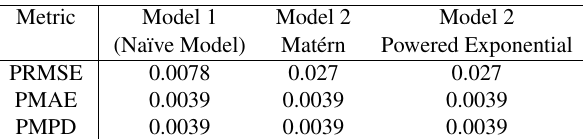
Table 7. Model 3 - p -values for paired Wilcoxon test